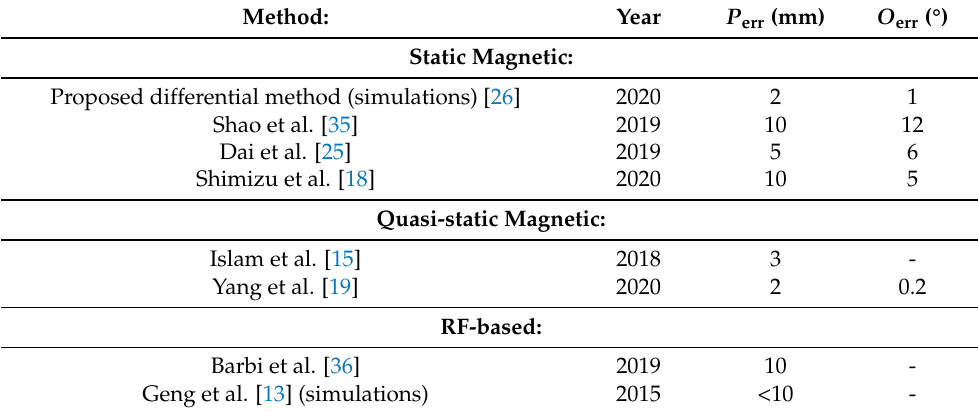
Table 5. Comparison of state-of-the-art localization methods for capsule endoscopes. For the pro- posed differential method, non-ideal conditions, rotation of the entire system, and a magnet of length 10 mm were